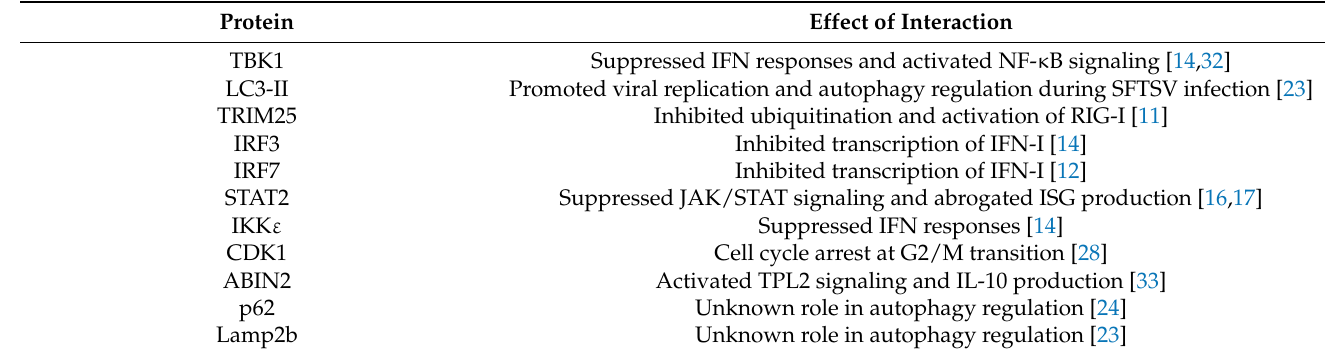
Table 1. List of host proteins to which NSs interacts.